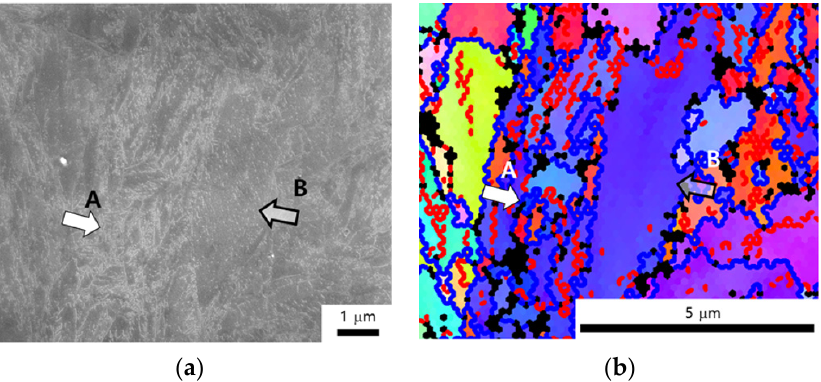
Figure 6. SEM image ( a ) and IPF map ( b ) of QT specimen. The white regions in ( a ) represent ce- mentite.